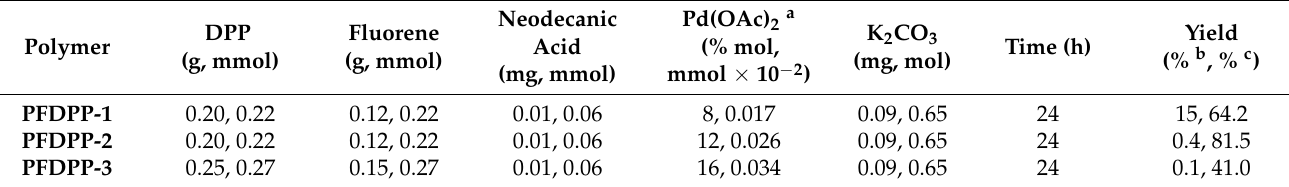
Table 1. Summary of the parameters used in the synthesis for PFDPP